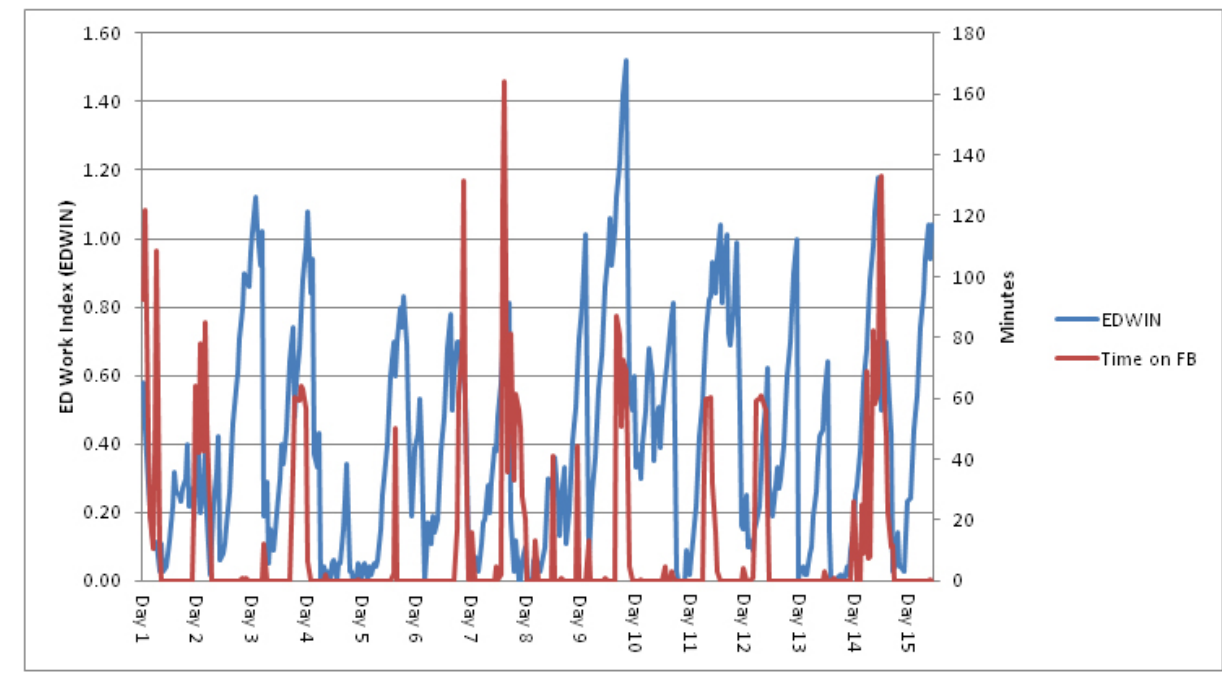
Figure 1. The relationship between Facebook use and ED business.